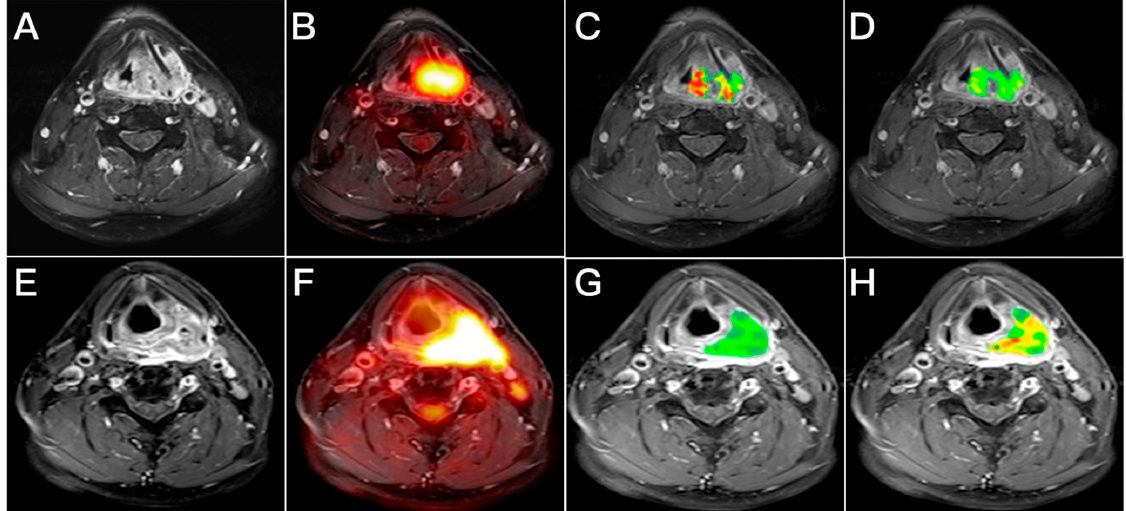
Figure 3. Integrating TN classification with MRI perfusion biomarkers aided in predicting recurrence-free survival. ( A – D ) Representative axial images of a primary hypopharyngeal cancer patient with T4aN0 disease. ( A ) Contrast-enhanced MR image; ( B ) 18 F-FDG PET/MRI image; ( C ) Contrast-enhanced MR image with an overlaid K trans map of the primary tumor; and ( D ) Con- trast-enhanced MR image with an overlaid iAUC map of the primary tumor. This patient had a high K trans value of 416 × 10 − 3 min − 1 and a low iAUC value of 424. This patient had local tumor re- currence 12 months after chemoradiotherapy. ( E – H ) Representative axial images of a primary hy- popharyngeal cancer patient with T4aN2b disease. ( E ) Contrast-enhanced MR image; ( F ) 18 F-FDG PET/MRI image; ( G ) Contrast-enhanced MR image with an overlaid K trans map of the primary tu- mor; and ( H ) Contrast-enhanced MR image with an overlaid iAUC map of the primary tumor. He had a low K trans value of 117 × 10 − 3 min − 1 and a high iAUC value of 1044. This patient survived without disease recurrence 5 years after chemoradiotherapy.